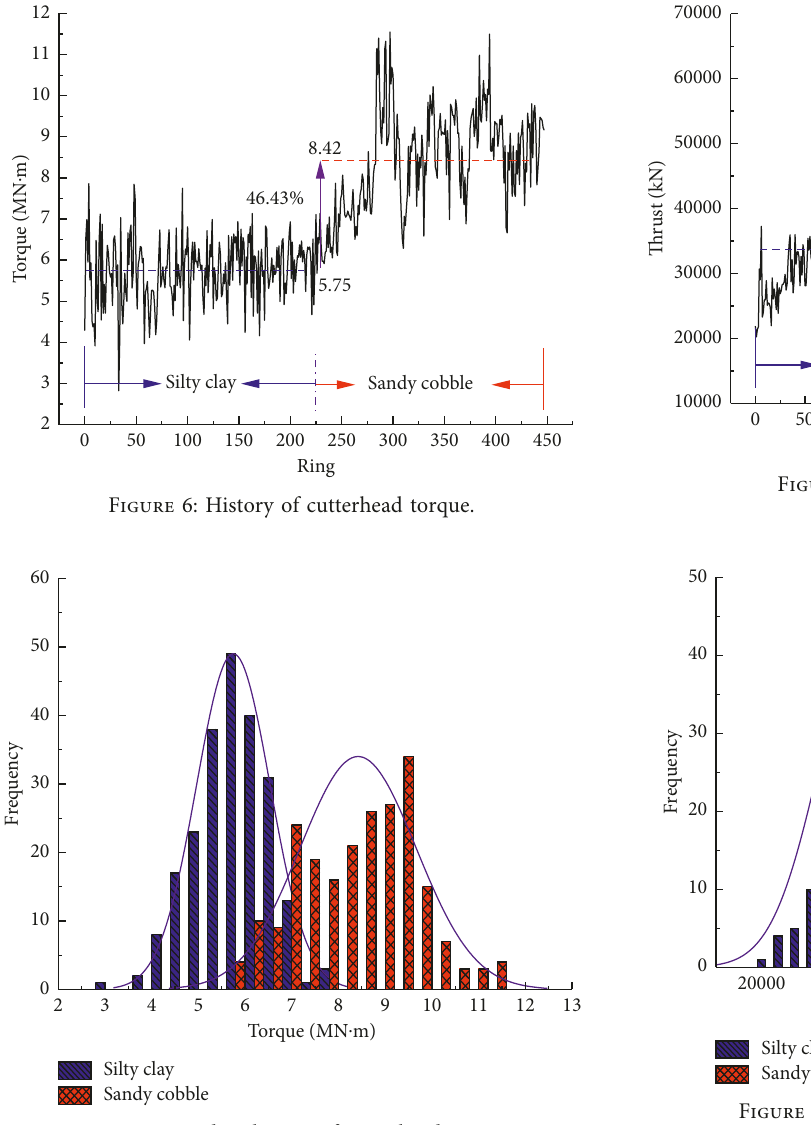
Figure 7: Bar distribution of cutterhead torque.